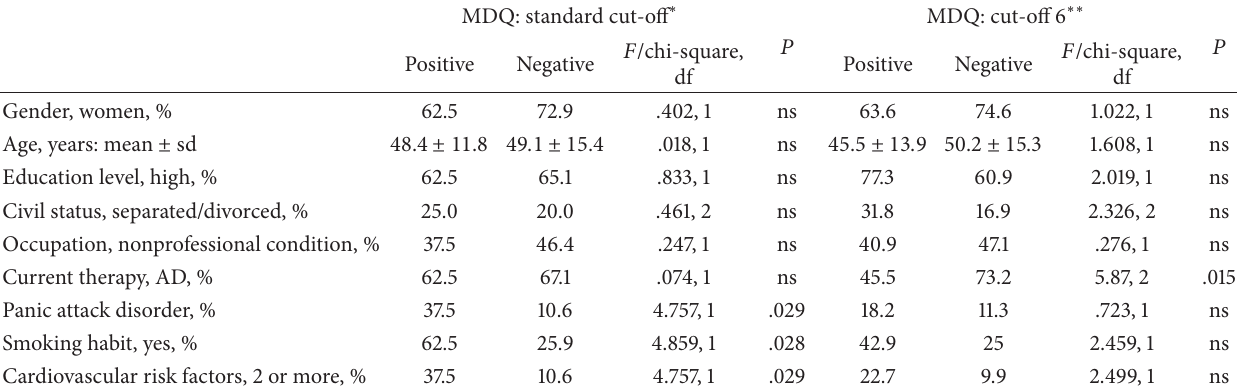
Table 5: Demographic and clinical characteristics according to threshold score on the MDQ.